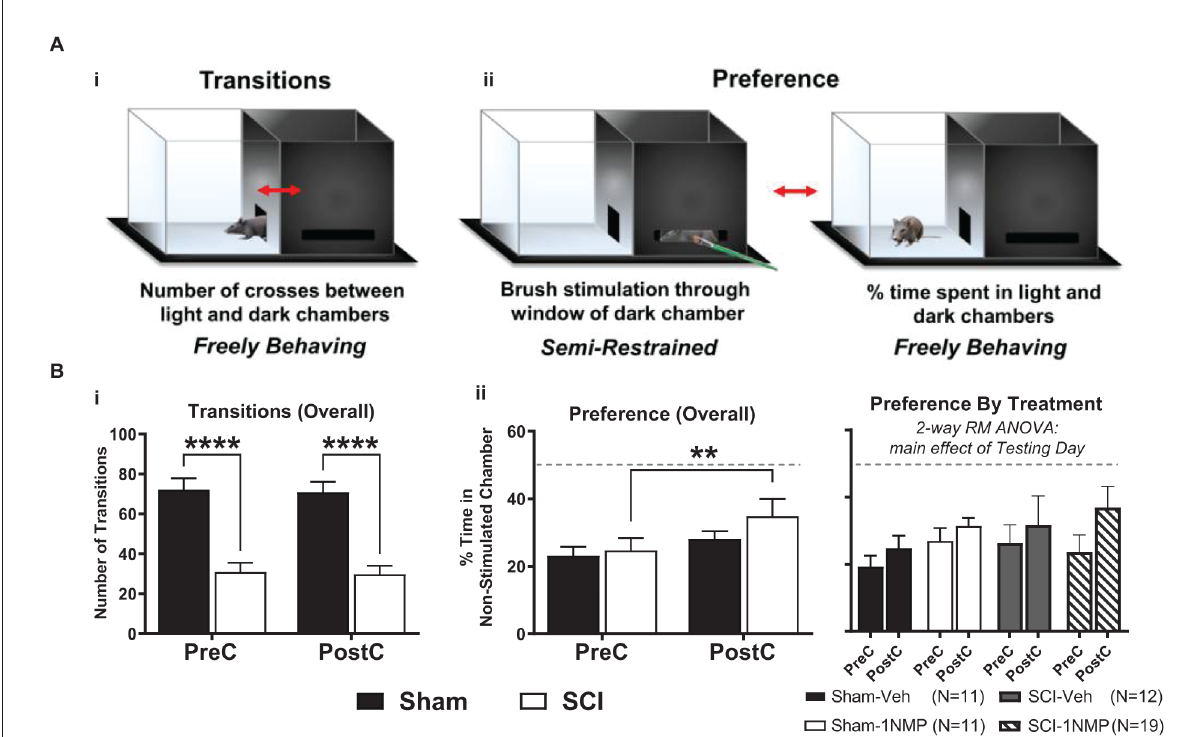
FIGURE4 TrkBinhibitiondoesnotblockconditionedplaceaversion(CPA). (A) Thedualchamber(“lightanddark”)CPAapparatuswithamouseshowninside, visually depicting how: (i) side-to-side transitions are quantified, and (ii) animal preferences are determined by monitoring time spent in each chamber during periods of free exploration, before and after brush stimulation. (B) (i) SCI mice had fewer transitions before and after stimulation thereby revealing continued locomotor impairment several weeks after injury (**** p < 0.0001 SCI vs. Sham). (ii, left) SCI mice receiving mechanical brush stimulation while partially restrained in the dark chamber developed a preference for the light chamber post-stimulation (** p < 0.005 pre vs. post). (ii, right) Results broken down by treatment (vehicle or 1NMP) for all SCI and Sham mice, illustrating that 1NMP treatment did not alleviate affective pain behavior. PreC, pre-conditioning; PostC, post-conditioning. The dashed horizontal line in (B) indicates 50% time spent in each chamber (no